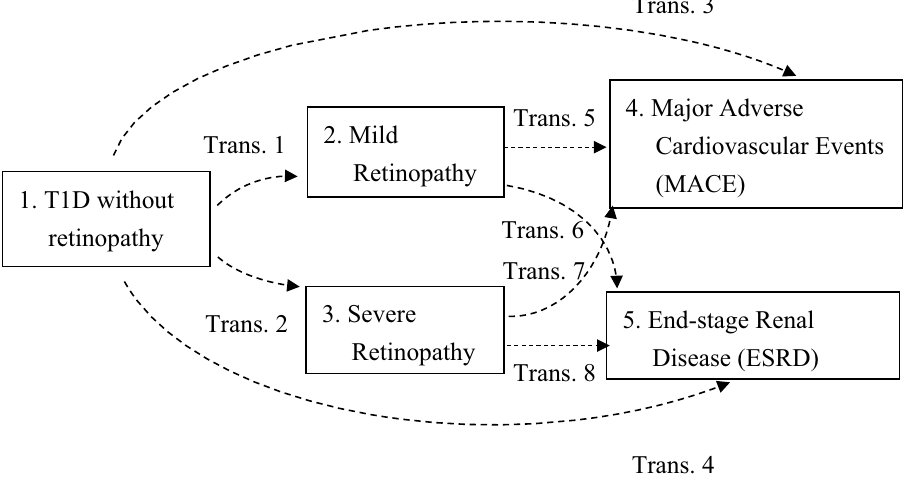
Figure 1. Five-state model with 8 transition for type 1 diabetes patients. All patients started in State 1. Trans 1: patients moved to mild DR form type 1 DM; Trans 2: patients moved to severe DR form type 1 DM; Trans 3: patients moved to MACE form type 1 DM; Trans 4: patients moved to ESRD form type 1 DM; Trans 5: patients moved to MACE form mild DR; Trans 6: patients moved to ESRD form mild DR; Trans 7: patients moved to MACE form severe DR; Trans 8: patients moved to ESRD form severe